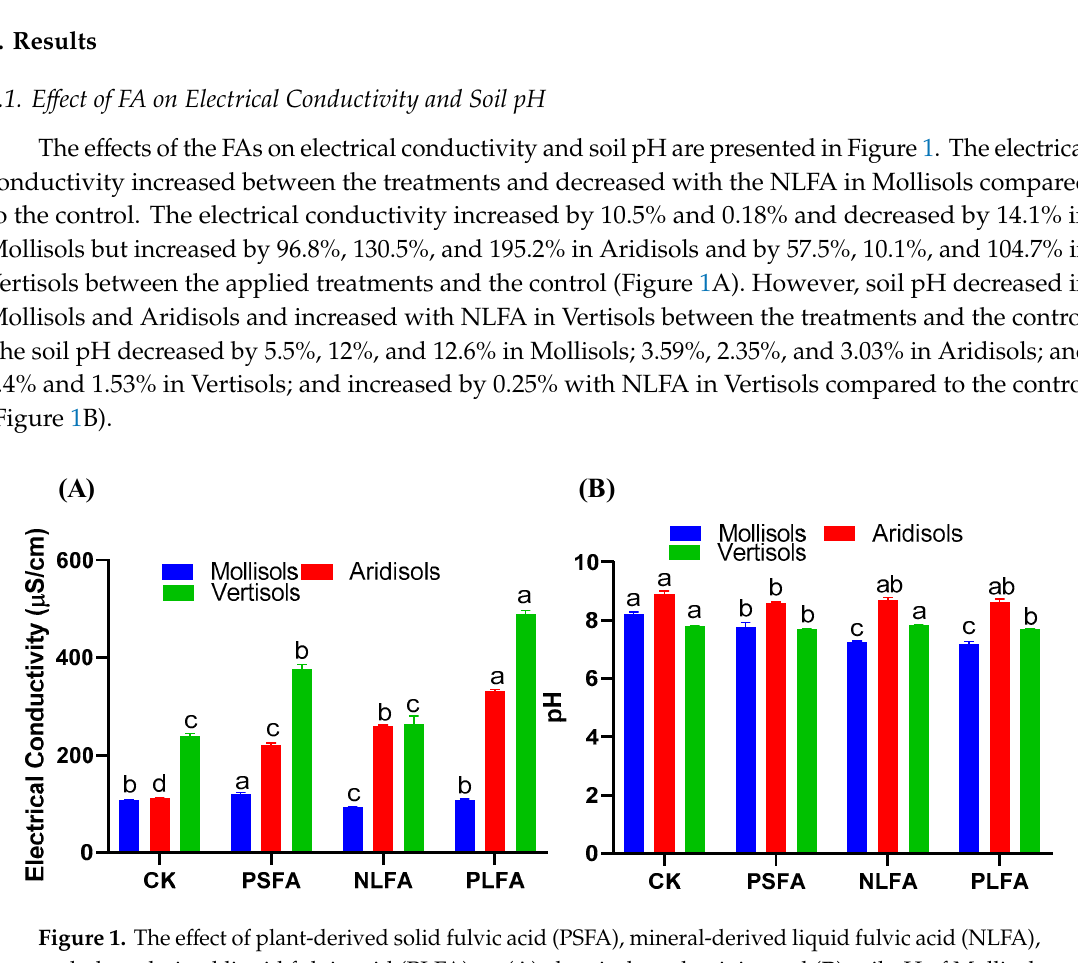
Figure 1. The effect of plant-derived solid fulvic acid (PSFA), mineral-derived liquid fulvic acid (NLFA), and plant-derived liquid fulvic acid (PLFA) on ( A ) electrical conductivity and ( B ) soil pH of Mollisol, Aridisol, and Vertisol soils. The means ± standard errors are shown ( n = 4). Different letters (a, b, and c) indicate significant differences between the initial and final values of the soils based on a least significant difference test at a 5% significance level.